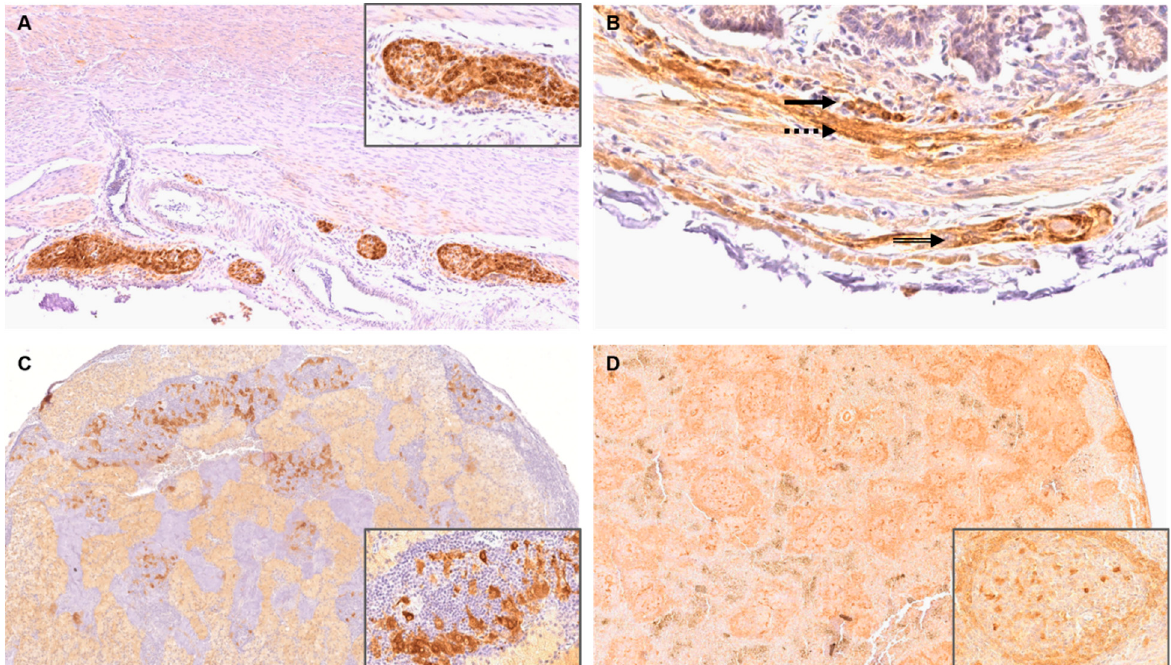
Figure 5. Immunohistochemistry (IHC) for the detection of viral antigen in peripheral organs of parrot bornavirus 4 (PaBV-4) infected cockatiels resembling widespread antigen distribution. IHC was performed by using the phosphoprotein (P) antibody directed against the bornaviral phosphoprotein (P) with proven cross-reactivity against PaBV-4. ( A ) Gizzard of adult cockatiel B 0,1. Demonstration of PaBV-4 P in ganglion cells and a few round cells; original magnification ×100. ( B ) Intestine of adult cockatiel B 0,1. Demonstration of PaBV-4 antigen in ganglion cells of the plexus submucosus (arrow), nerve fibres (dashed arrow) and ganglion cells of the plexus myentericus (double lined arrow); original magnification ×400. ( C ) Adrenal gland of adult cockatiel D 1,0. Demonstration of PaBV-4 P in ganglion cells; original magnification ×100, magnification of insert ×400. ( D ) Spleen of adult cockatiel C0,1. Demonstration of PaBV-4 antigen in round cells; original magnification ×100, magnification of insert ×400.